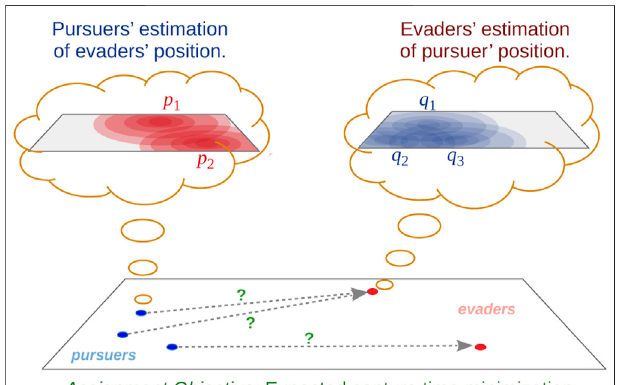
FIGURE 2 | Problem